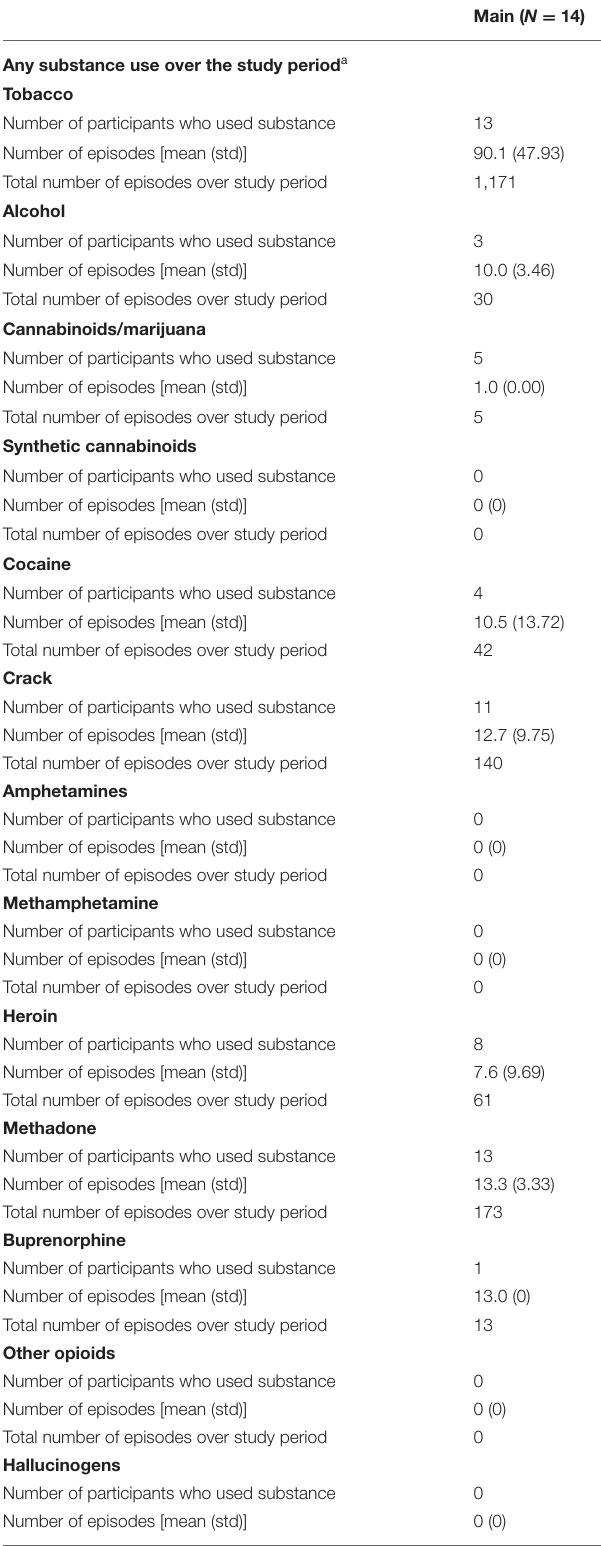
TABLE 6 | Summary of substance use in the main